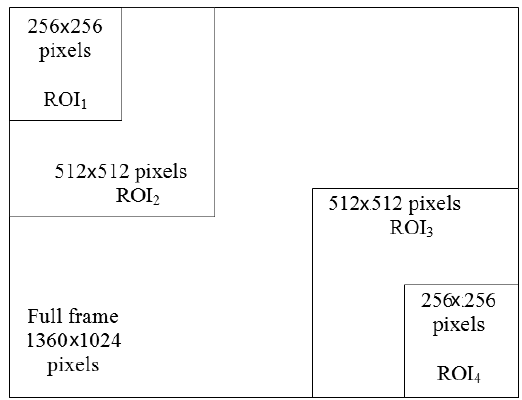
Fig. 7. Schematic representation of the ROIs used in our ex-